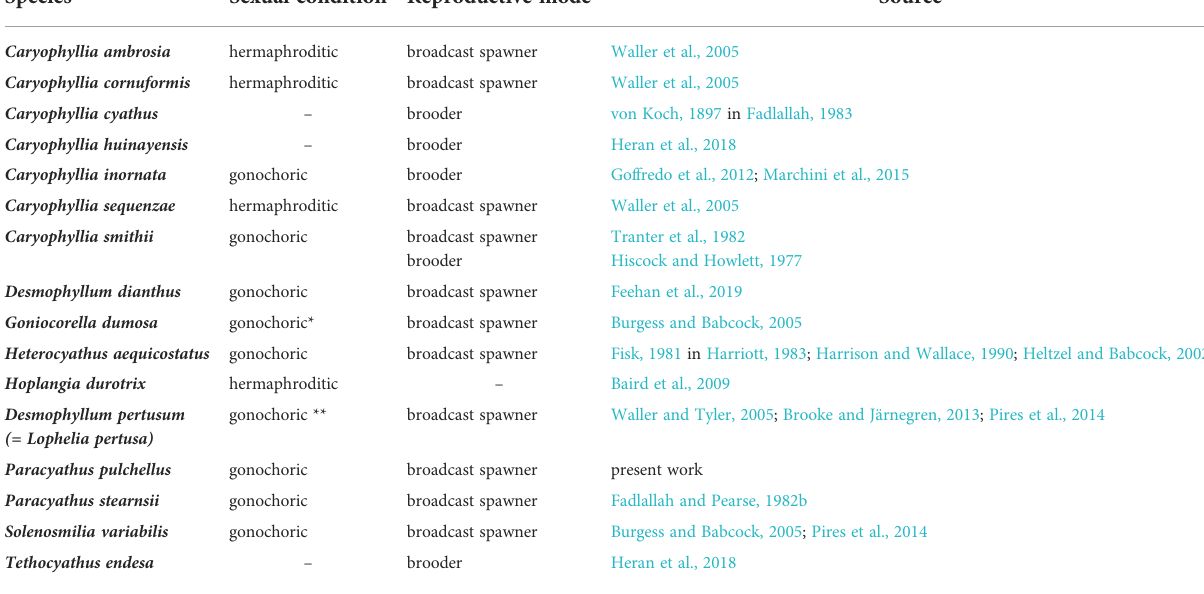
TABLE 3 Reproductive traits found in the literature on Caryophylliidae